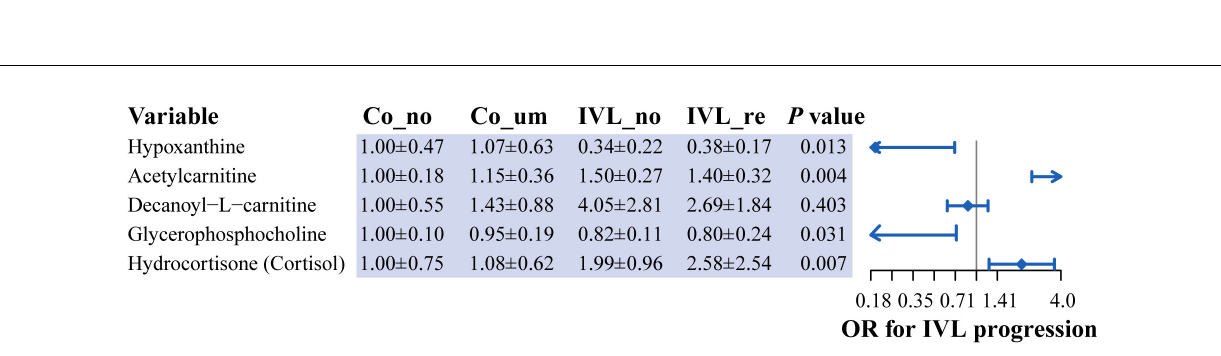
Frontiers in Cell and Developmental Biology |